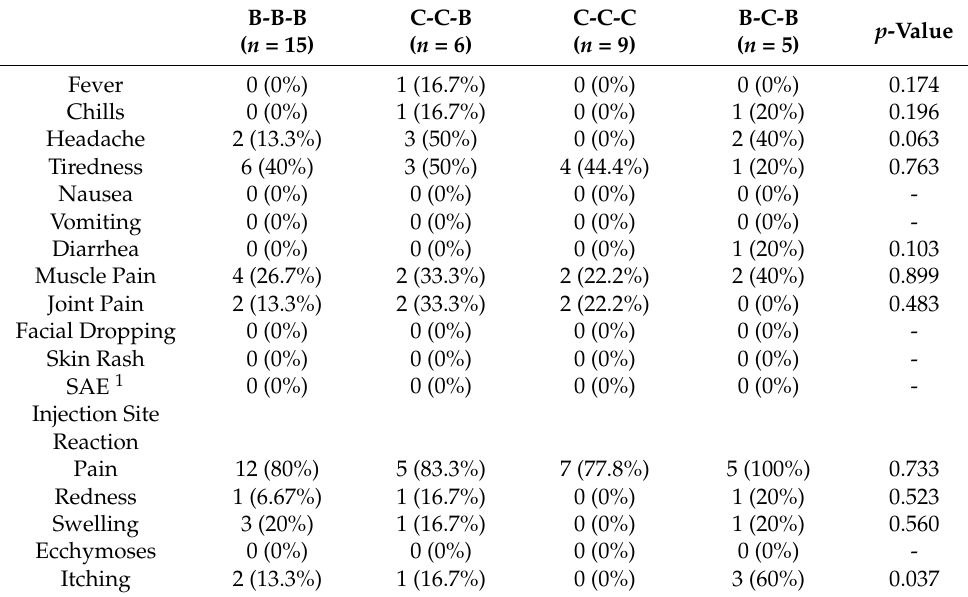
Table 3. Adverse